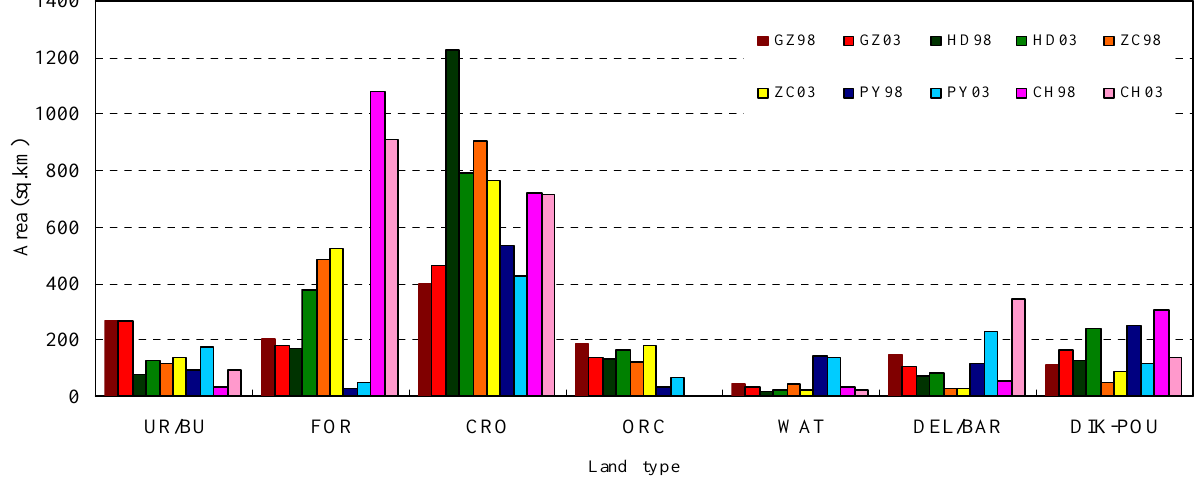
Figure 6. The land use areas of five counties. (Each kind of color column stands for a county, and each color column has two parts, which is the land use data of 1998 and 2003 from left to